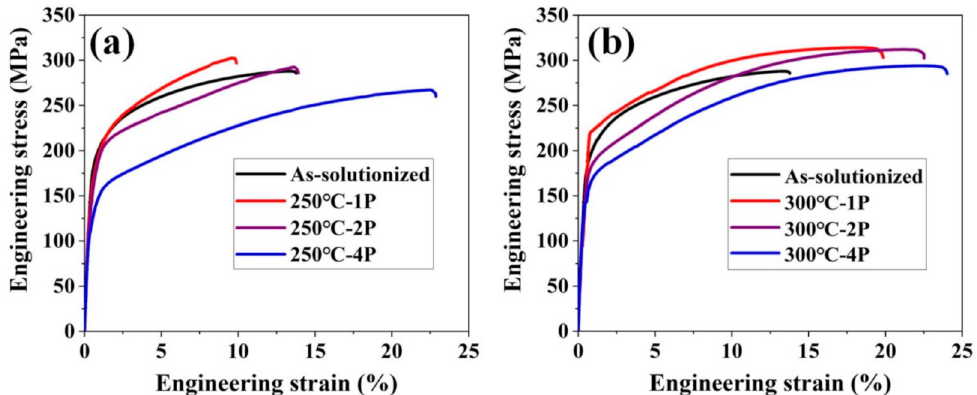
Figure 9. Tensile engineering stress–strain curves of as-solutionized samples and ECAPed samples.